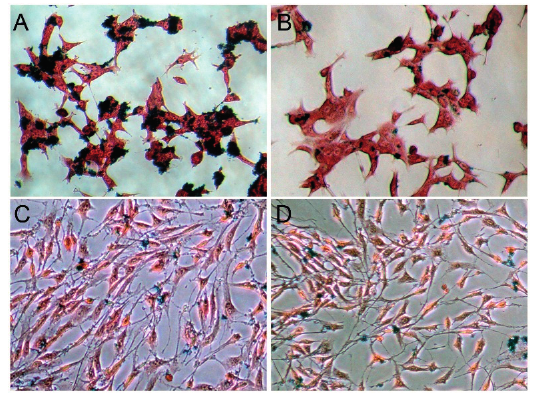
Figure 3. In vitro Prussian blue staining results (×200). ( A , B ) Prussian blue staining of LNCaP cells incubated with polypeptide-SPIONs and non-targeted SPIONs, respectively; ( C , D ) Prussian blue staining of PC3 cells incubated with polypeptide-SPIONs and non-targeted SPIONs, respectively.